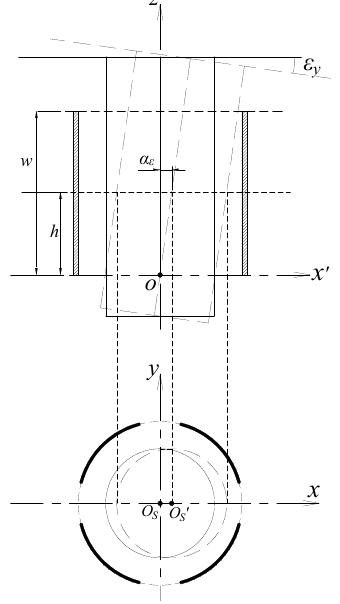
Figure 6. Schematic of the effect of tilt motion on the radial error motion measurement.